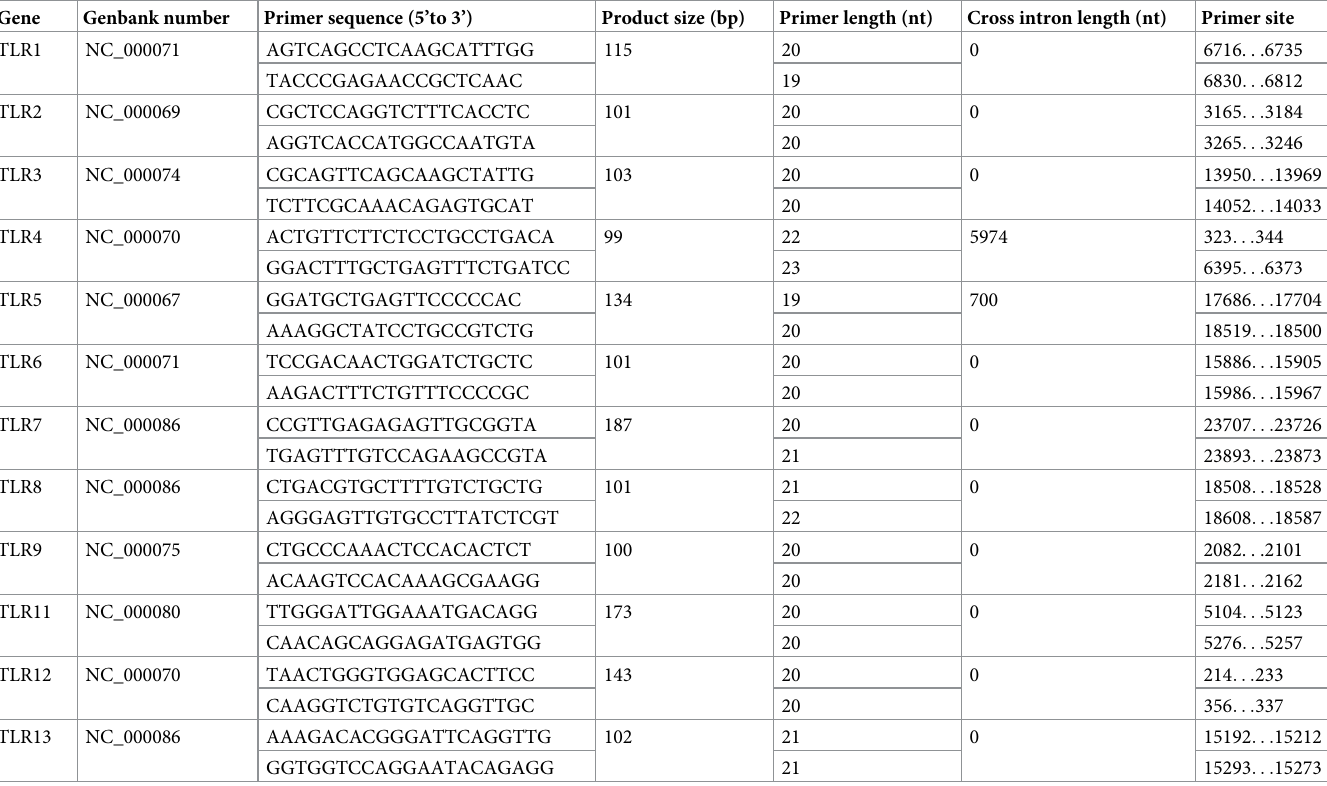
Table 2. Primers used for qRT-PCR analysis of TLRs.